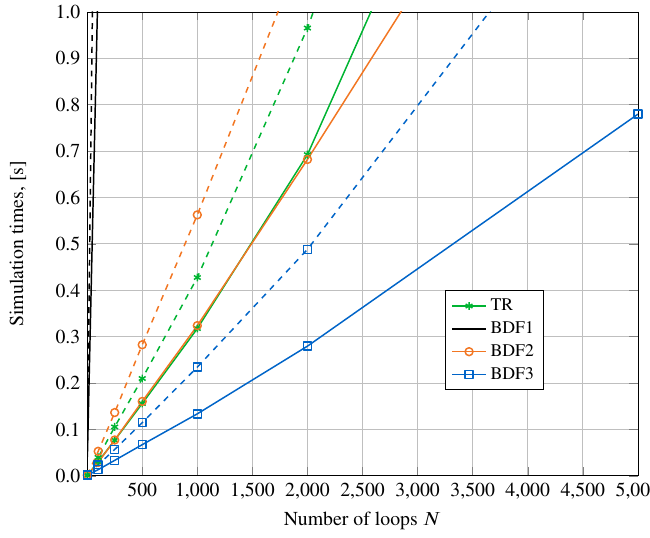
Figure 10. Scalable RLC circuit: Simulation time as a function of the number of loops ( N ) for low precision. Simulations with a constant tangent matrix are represented with solid lines; dashed lines mean refactorization of the tangent matrix in each solver iteration.